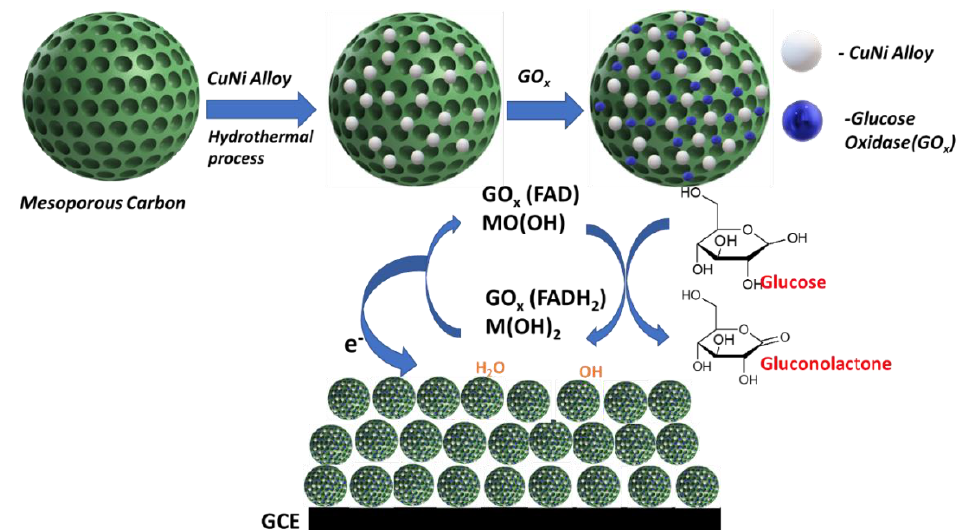
Scheme 1. Schematic illustration for glucose sensing mechanism based on CuNi-MC/GO x catalyst.